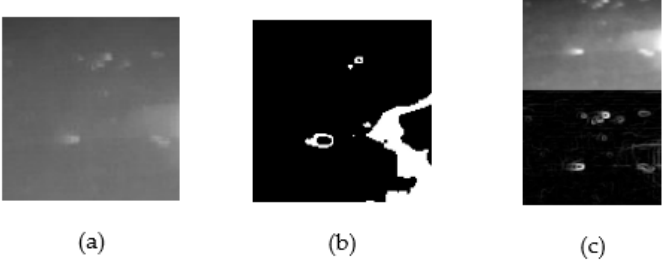
Figure 10. Pre-processing images: ( a ) grayscaling; ( b ) thresholding; ( c ) box blur and Sobel–Feldman filters.